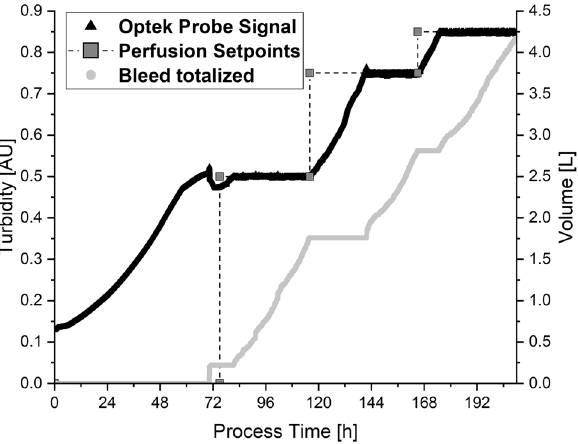
Figure 2. The turbidity signal in arbitrary units (AU, black triangles) during the control loop test run and the target setpoints in steps (dark gray squares). The corresponding bleed volume (light gray circles) was used to calculate growth rates during the cultivation phases with fixed cell concentrations.